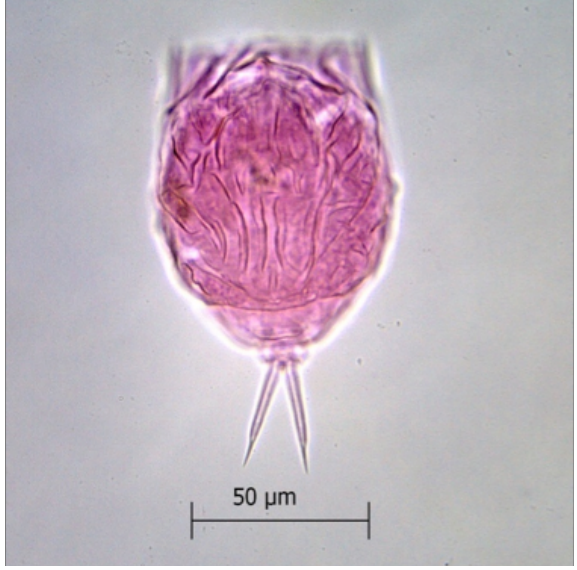
Image 6. Lecane haliclysta Harring & Myers, dorsal view Image 7. Lecane furcata (Murray), ventral